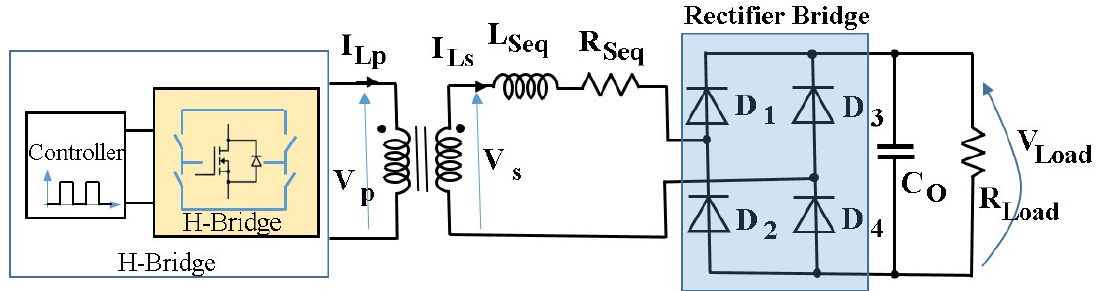
Figure 13. Simulation converter circuit and transformer secondary path arrangement for the simulation results.